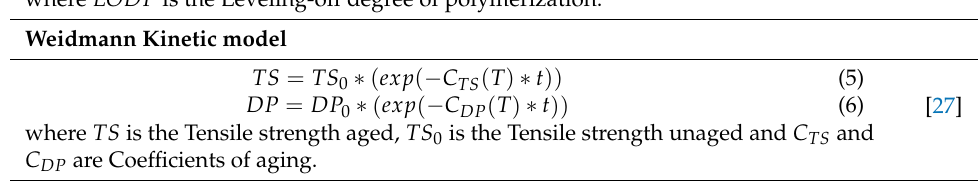
IEEE Kinetic model